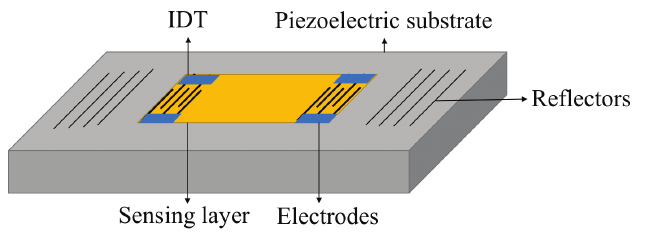
Figure 9. Schematic view of a SAW gas sensor consists of two arrays of